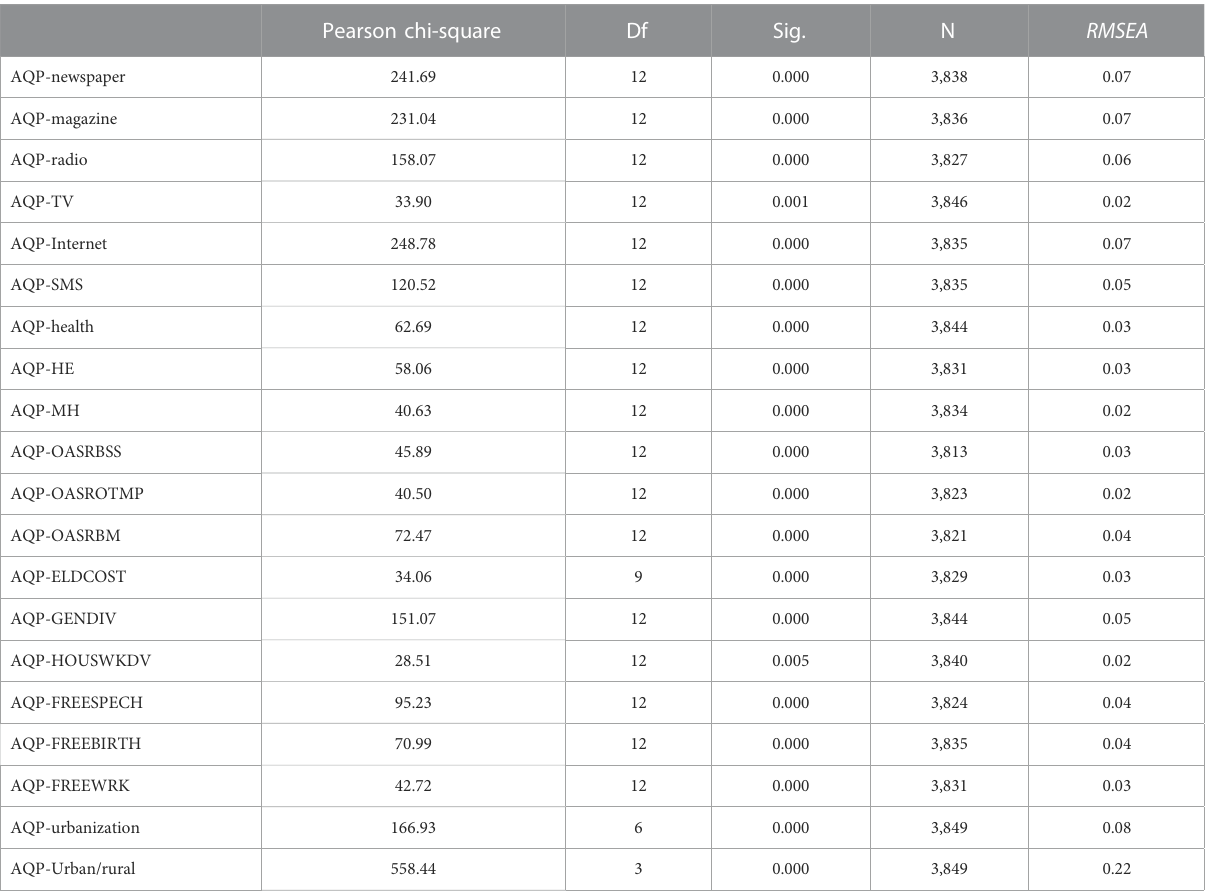
TABLE 1 Chi-square results and RMSEA value. Pearson chi-square